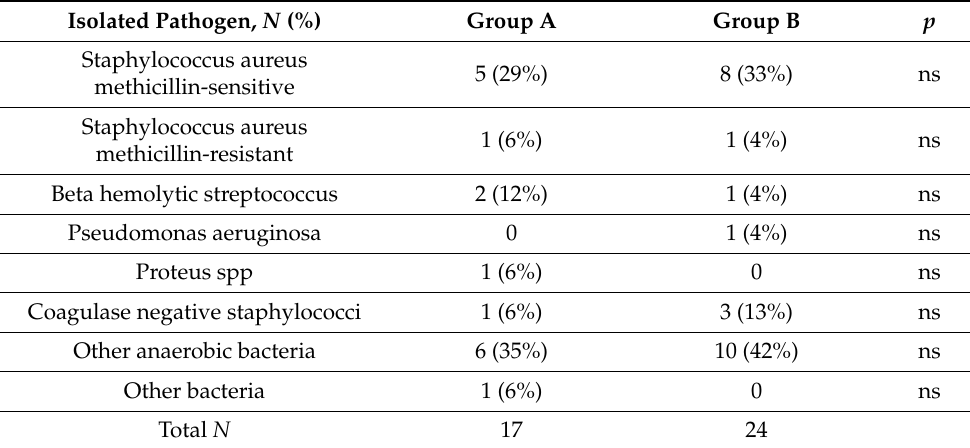
Table 2. Microbiological findings from bone sample